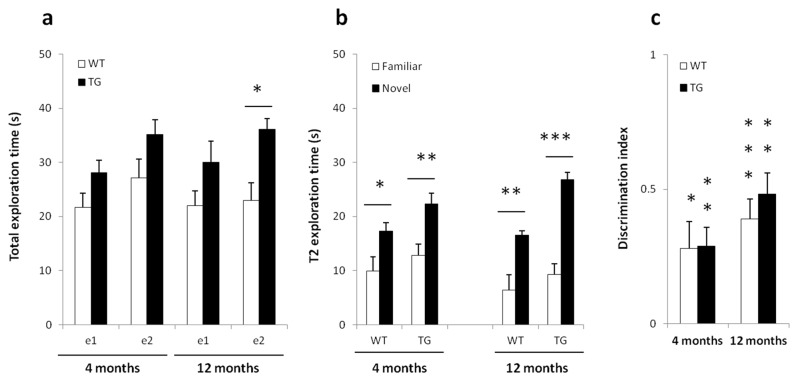
Object Recognition Test (ORT).Results are expressed as Mean ± SEM. Three WT rats of the 4 months old group and one WT rat from the 12 months old group were excluded from the analysis as they did not explore the objects (a) Exploration time (e1) and (e2) during T1 and T2 respectively. TG rats showed a significantly higher exploration time during e2 at 12 months of age. (b) Recognition testing during T2: 4 months and 12 months old BACHD rats had a significantly higher exploration time to the novel object than the familiar object. (c) The discrimination index (d2) for both groups are above zero and were significant at each age. Asterisks indicate statistical significance (*p < 0.05; **p < 0.01 and ***p < 0.001).